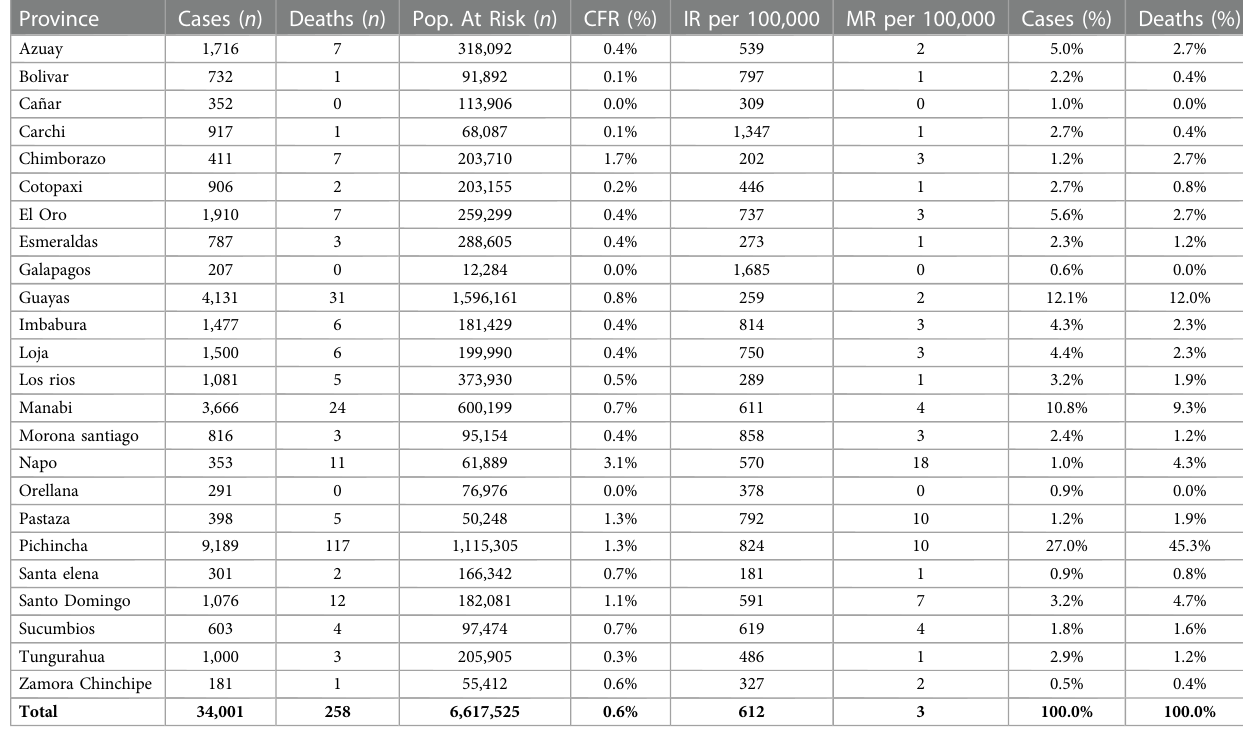
TABLE 4 Pediatric COVID-19 cases and deaths per province. Province